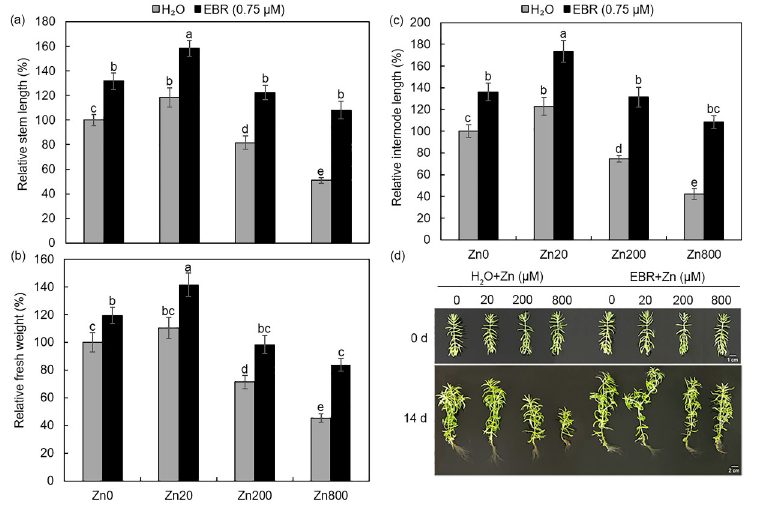
Fig 1. Effects of zinc and EBR treatments on growth indexes of S . lineare plants. (a) Relative stem length; (b) Relative fresh weight; (c) Relative internode length. (d) Photos of S . lineare treated with Zn and EBR for 14 d.